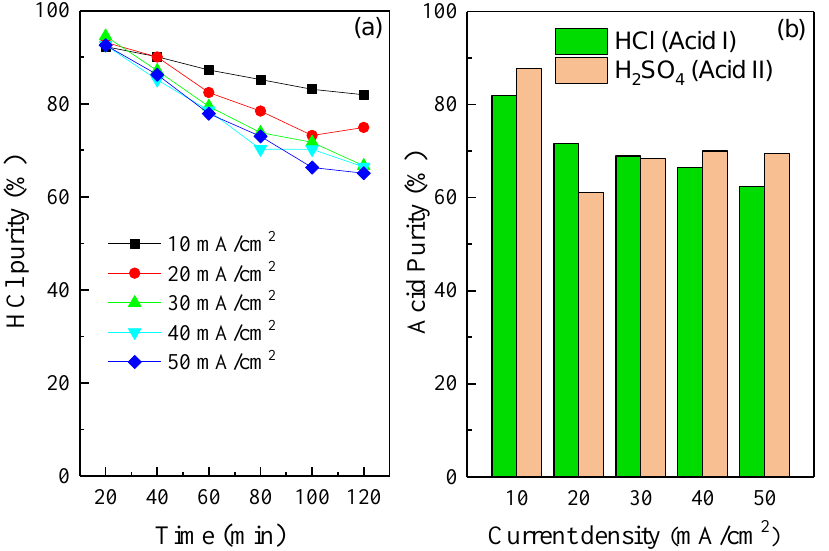
Figure 5. Effect of the current density on acid purity. ( a ) The evolution of HCl purity in the acid I compartment as a function of time; ( b ) the final HCl and H 2 SO 4 purity in the acid I and acid II compartments after the experiments, respectively. Other experimental conditions: feed in salt compartment, 0.05 mol/L NaCl + 0.05 mol/L Na 2 SO 4 ; electrode rinse solution, 0.3 mol/L Na 2 SO 4 ; flow rate of each circulation, 200 mL/min.